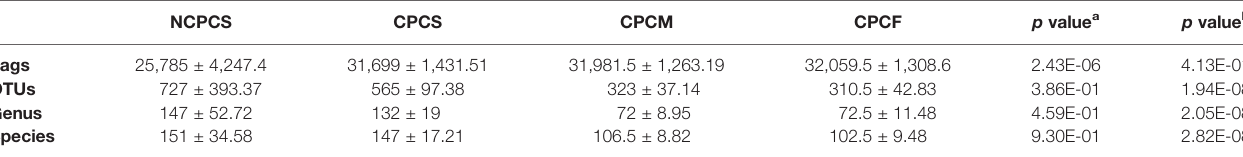
TABLE 2 | Distribution and distinction of tags, OTUs, genus, and species number in each group. NCPCS CPCS